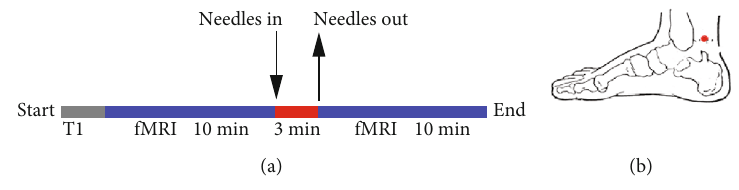
Figure 1: Trial fl owchart (a) and location of acupoints KI3